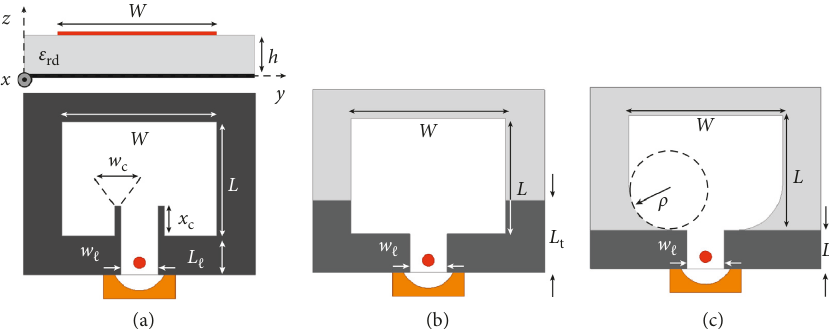
Figure 2: Printed antennas modifications: (a) microstrip antenna, (b) printed monopole antenna, and (c) ultra-wideband printed antenna.